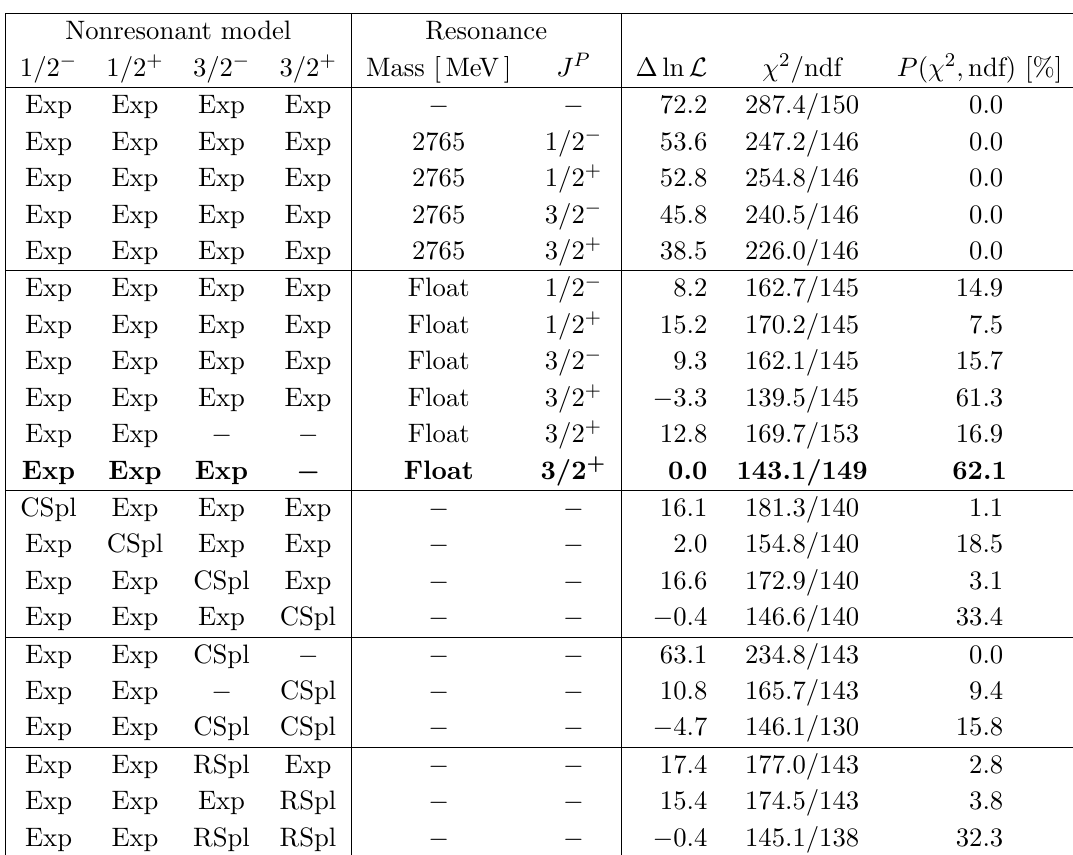
Table 5 . Quality of various (cid:12)ts to the near-threshold D 0 p data. The models include nonresonant components for partial waves with J (cid:20) 3 = 2 with or without a resonant component, whose mass is (cid:12)xed to 2765 MeV or allowed to vary (\Float"). \Exp" denotes an exponential nonresonant lineshape, \CSpl" a complex spline parametrisation, and \RSpl" a real spline parametrisation multiplied by a constant phase. The baseline model is shown in bold